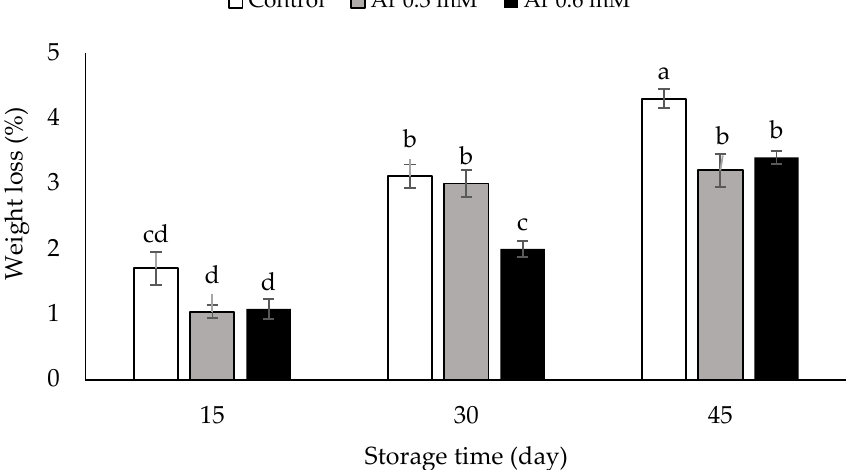
Figure 4. The effect of different levels of postharvest treatment of L-arginine on the weight loss of persimmon cv. “Karaj” fruits during cold storage (DMRT, p ≤ 0.05). The values of data are average of n = 3, and bar represents standard error of the means. Different letters above the bars show significant difference at p < 0.05 by Duncan’s multiple range test.